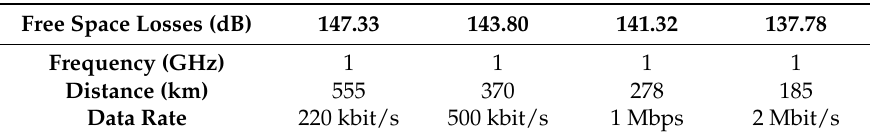
Table 1. Propagation parameters in long-range transmission.